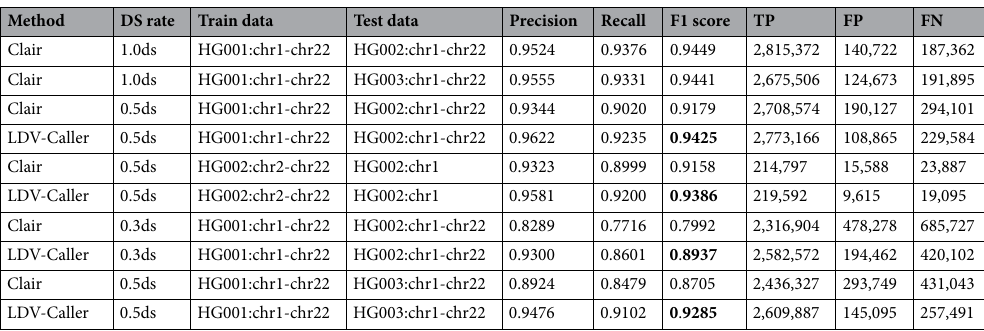
Table 1. Experimental results on GIAB dataset. We used chromosomes 1 to 22 of samples HG001, HG002, and HG003. The suffix ’ds’ indicates down-sampled rate. Both SNPs and Indels are used to make overall evaluations.